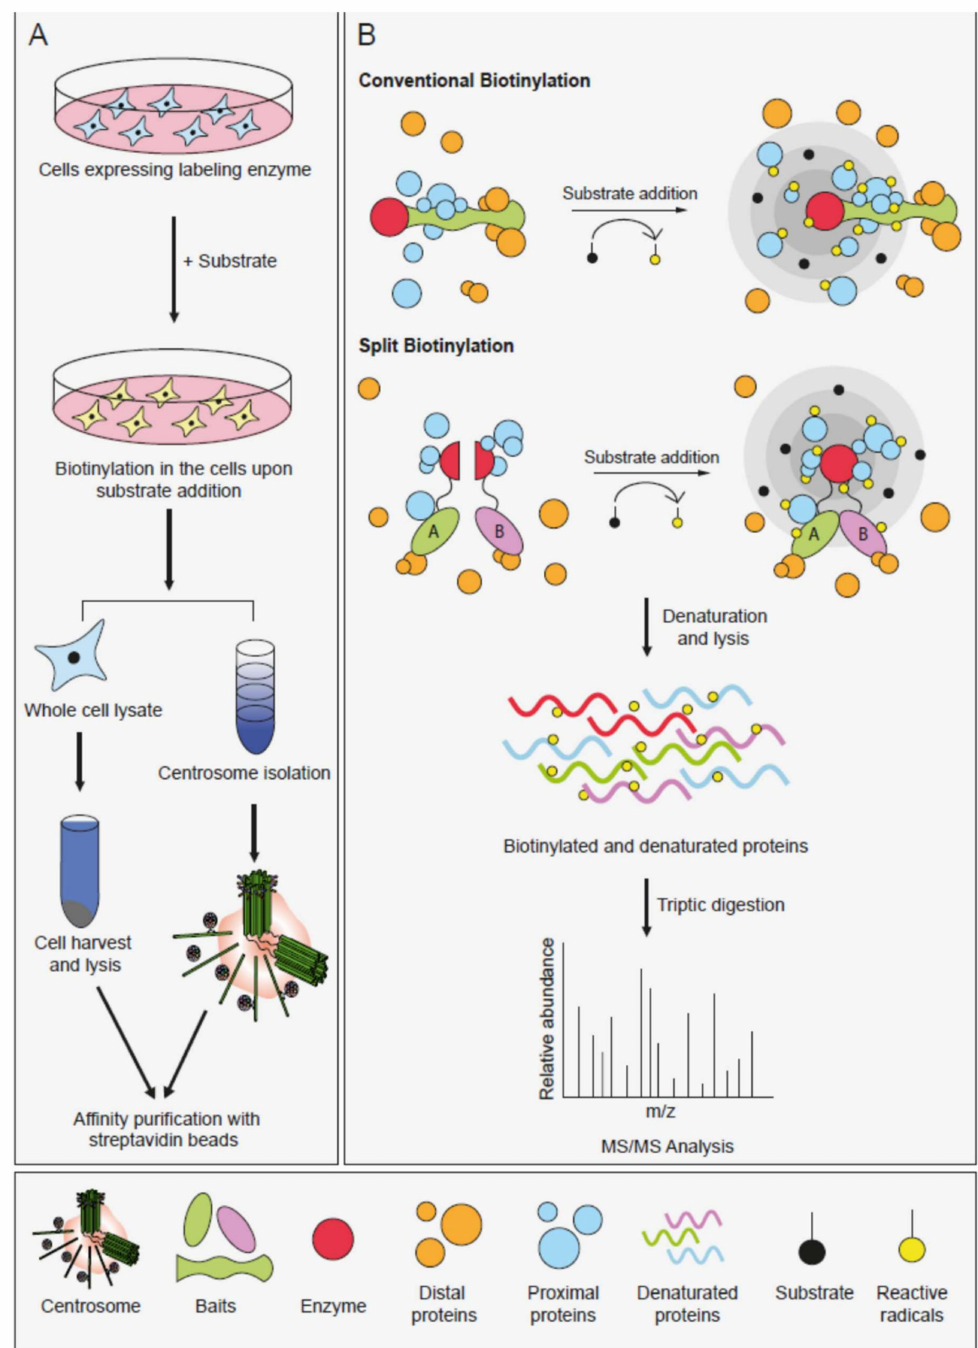
Figure 3. Overview of the proximity-based labeling techniques and their application to the centrosome. ( A ) Workflow of the application of proximity-based labeling to centrosomes. Cells that express proteins fused to proximity-based labeling enzymes are incubated with the labeling substrates (biotin or biotin-phenol). After biotinylation, cells are harvested and processed for the identification of biotinylated proteins in two di ff erent ways. First, centrosomes are enriched by sucrose gradients and the enriched fractions are solubilized under denaturing conditions. Second, cells are solubilized under denaturing conditions. Following lysis, the biotinylated proteins are captured by streptavidin beads and analyzed by mass spectrometry. ( B ) Schematic representation of conventional and split